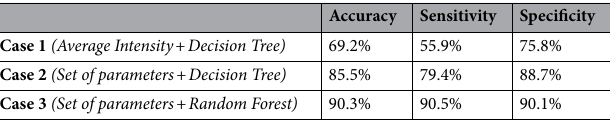
Table 1. The statistical summary of the SWIR otoscopy performance for all considered